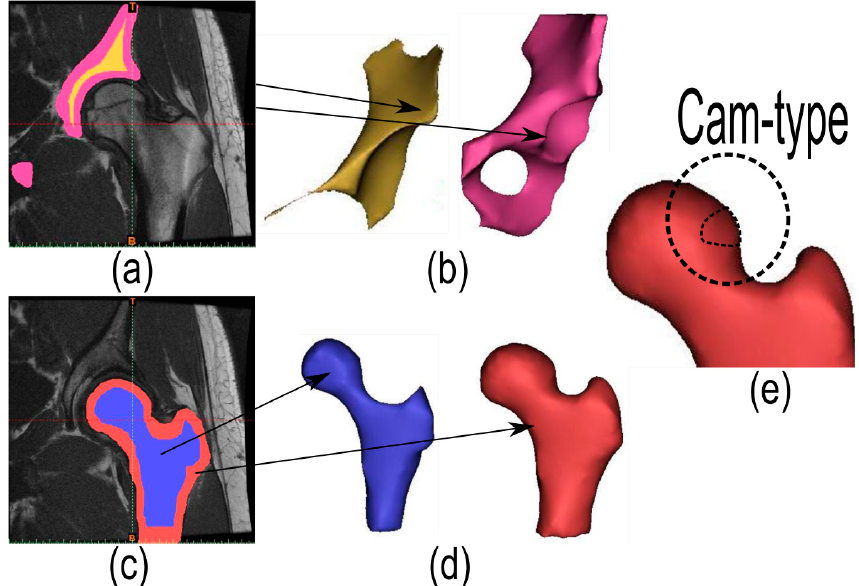
Figure 3. Segmentation process and generation of the masks: ( a ) pelvic segmentation, ( b ) pelvic cancellous and cortical bone masks, ( c ) femur segmentation and ( d ) femur cancellous and cortical bone masks (with Cam-type).